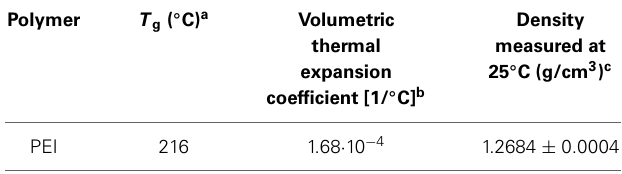
Table 4 | Thermophysical properties of PEI films.